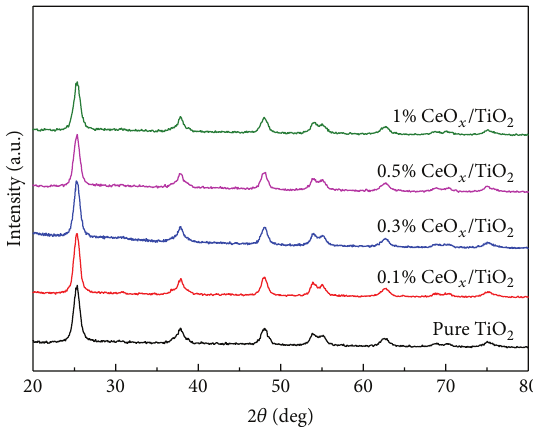
Figure 1: XRD patterns of 𝑥 % CeO 𝑥 /TiO 2 nanoparticles obtained from